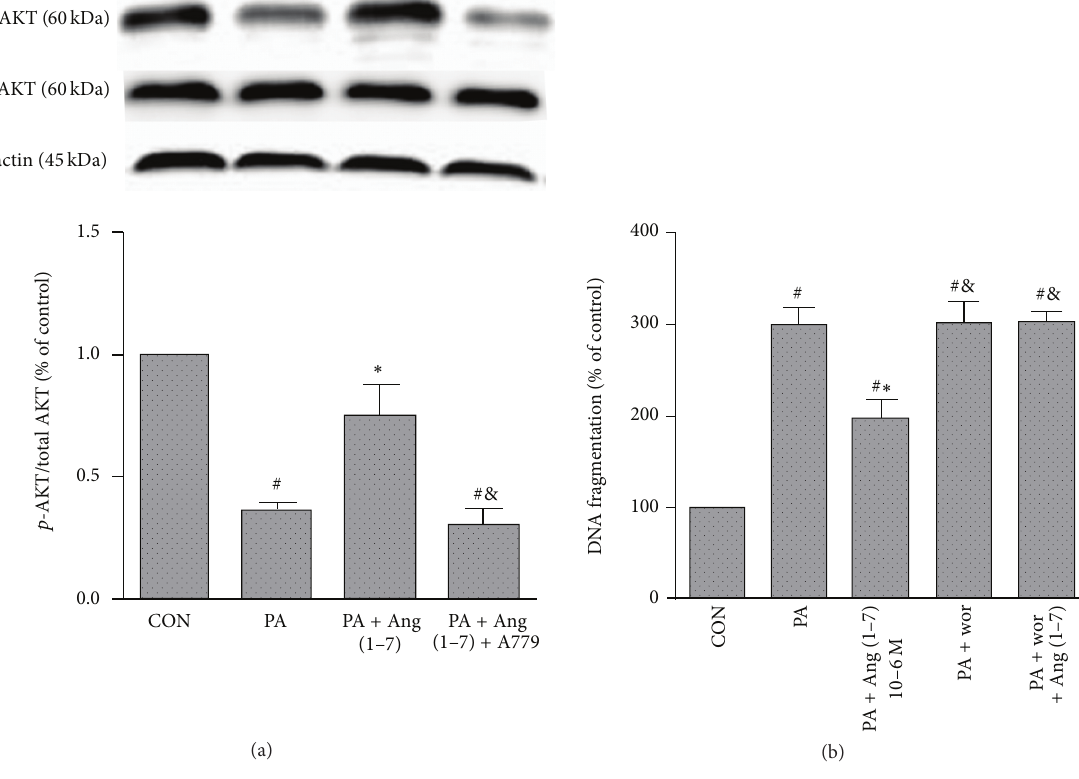
Figure 3: Effect of AKT pathway on antilipoapoptosis effect of Ang (1–7). AKT phosphorylation was measured in MS-1 cells which were exposed to palmitate (0.25 mmol/L) for 24 h, alone or in combination with Ang (1–7) (10 −6 mol/L) and A779 (10 −5 mol/L) (a). Wortmannin (10 −6 mol/L) blocked the antilipoapoptosis effect of Ang (1–7) (b). Values are mean ± SEM, 𝑛 = 3 for each group. # 𝑃 < 0.05 versus CON; ∗ 𝑃 < 0.05 versus PA; & 𝑃 < 0.05 versus PA + Ang